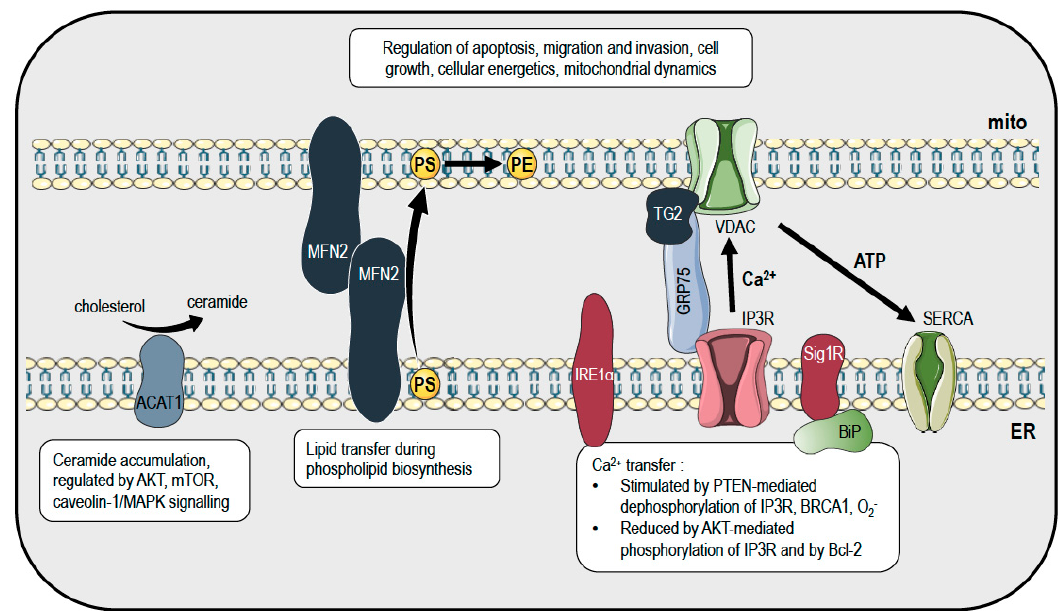
Figure 1. Cancer-relevant interactions between mitochondria and the ER at mito–ER contact sites (MERCs). Calcium transfer from the ER to mitochondria through the IP3R–GRP75–VDAC complex modulates mitochondrial energy metabolism and apoptosis induction, and is regulated by post-translational modifications of IP3R, ROS and associations with proteins such as TG2 and BRCA1. Further, proteins such as IRE1 α and the Sig1R-BiP complex can interfere with the calcium transfer. Mitochondrial ATP, on the other hand, is important for the correct functioning of SERCA, and thus ER calcium homeostasis. These mechanisms influence, amongst others, cancer cell proliferation, invasion, cell death and mitochondrial dynamics. In addition to calcium, lipid homeostasis is also regulated at MERCs. MFN2 is important for the transfer of phosphatidylserine (PS) from the ER to mitochondria, where it is converted to phosphatidylethanolammine (PE), while the MAM-resident protein ACAT1 converts cholesterol to ceramide, a sphingolipid often abundantly found in cancer. Impaired lipid homeostasis has been associated with di ff erent kinds of tumors, such as liver, breast, pancreatic and colon cancers. For abbreviations, please refer to the text. This figure was created using images from Servier Medical Art (http: // smart.servier.com). Servier Medical Art by Servier is licensed under